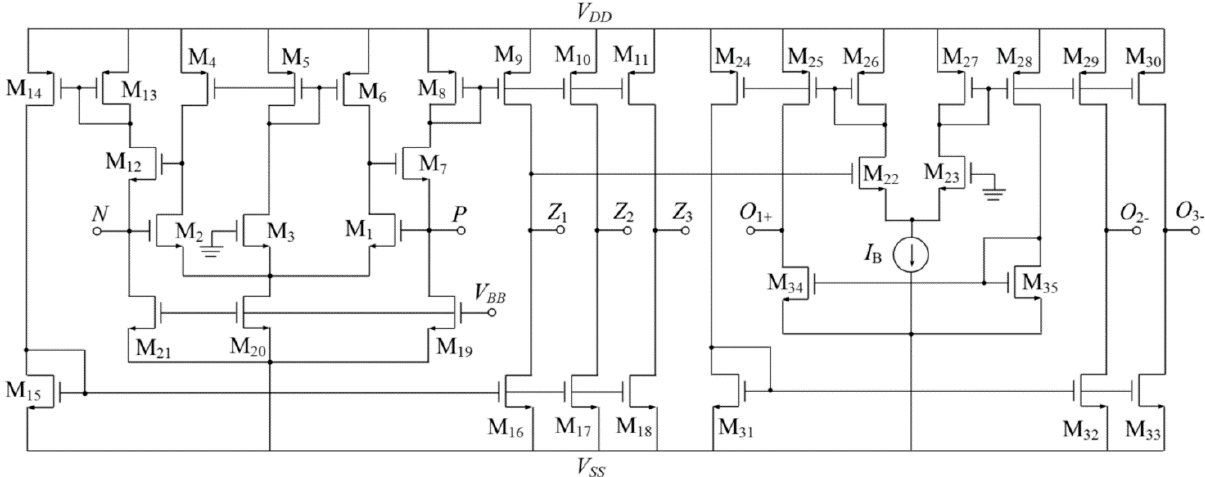
Figure 3. CMOS implementation of MOCDTA. Table 1. W/L ratios of MOS transistors.